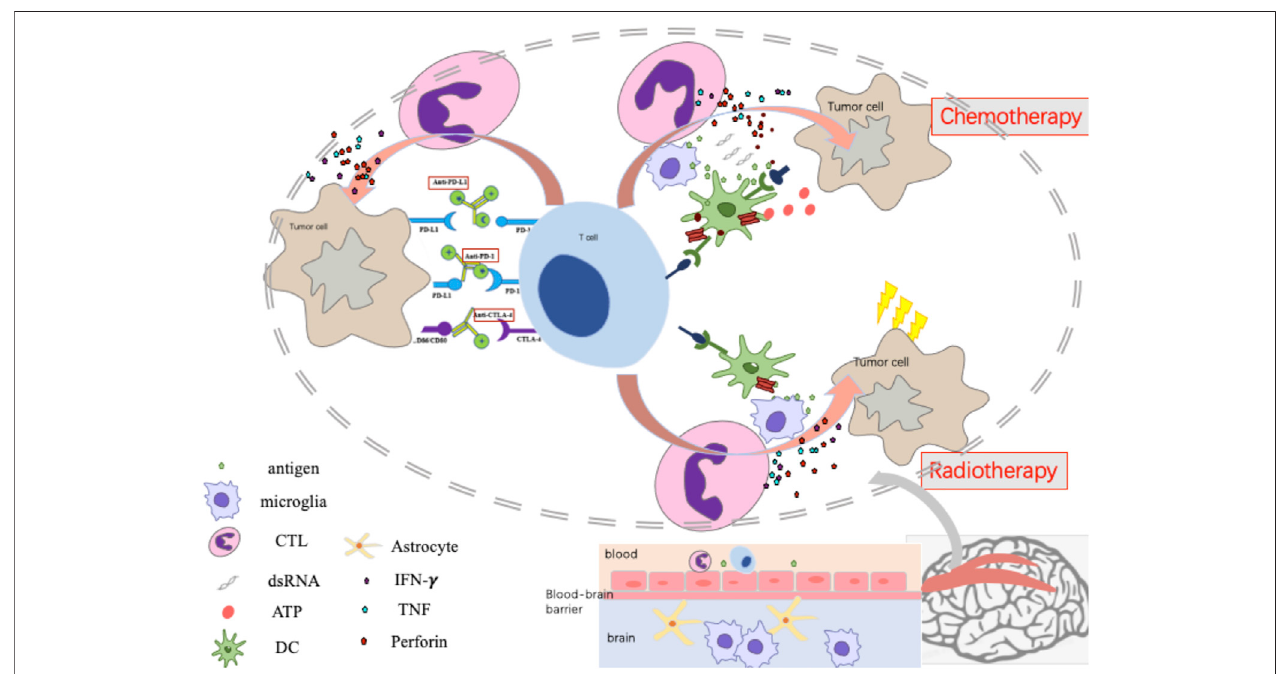
FIGURE 1 | The mechanism of Immunotherapy monotherapy, Immune-checkpoint inhibitor combined with Chemotherapy or Radiotherapy.